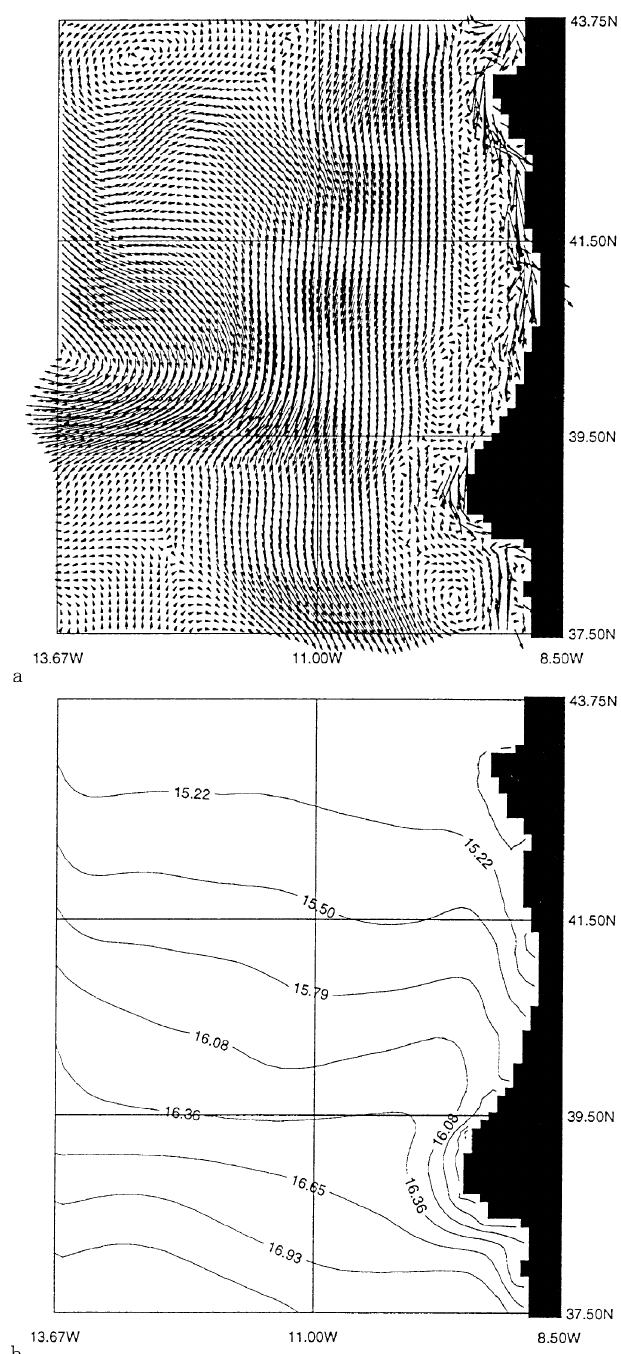
Fig. 4. a Winter velocity field at level 2 (32 m) and b winter temper- ature at level 1 (10.3 m) for case B with boundary stream function from the CME North Atlantic model, annual mean surface and boundary relaxation of tracers, and driven by Hellerman and Rosen- stein